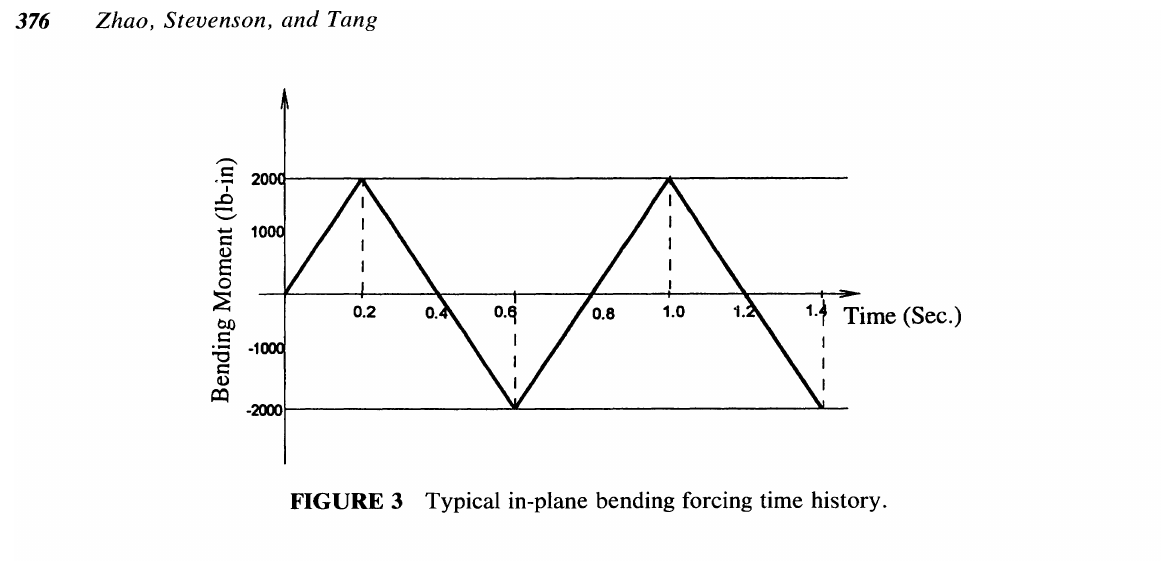
FIGURE 3 Typical in-plane bending forcing time history.